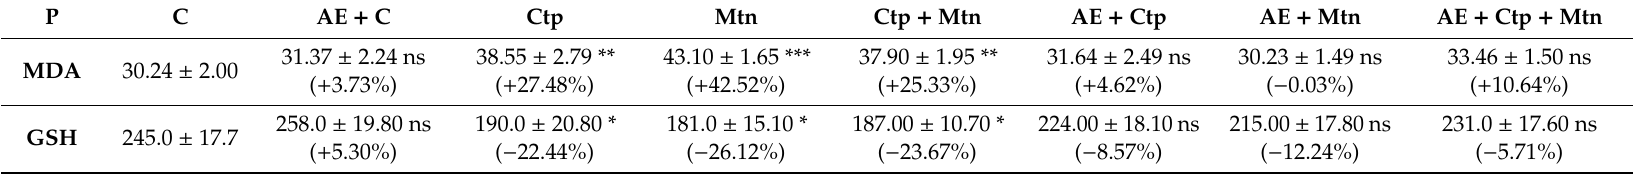
Table 3. E ff ect of cartap, malathion and A. vera extract on MDA and GSH in the Wistar rat blood